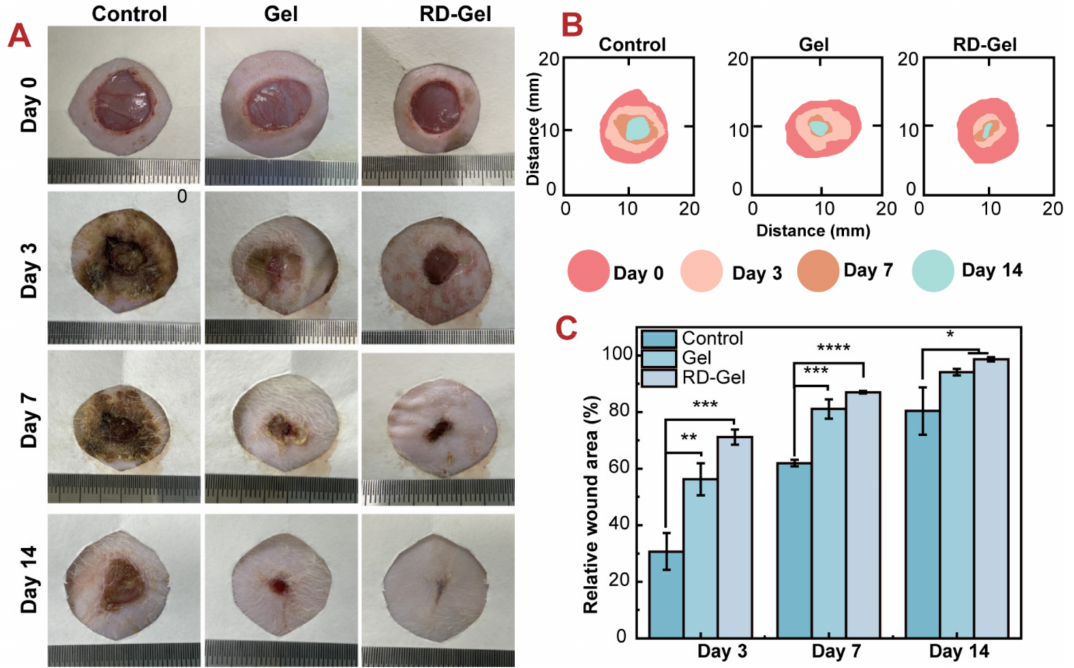
Figure 5. ( A ) Photographs of wounds on model animals with PBS, Gel, and RD-Gel at day 0, 3, 7, and 14. ( B ) simulation of the wound area on different days. ( C ) Statistical results of the remained wound area (%) of each group on different days. For statistical analysis, * represents p < 0.05, ** represents p < 0.01, *** represents p < 0.001, **** represents p <